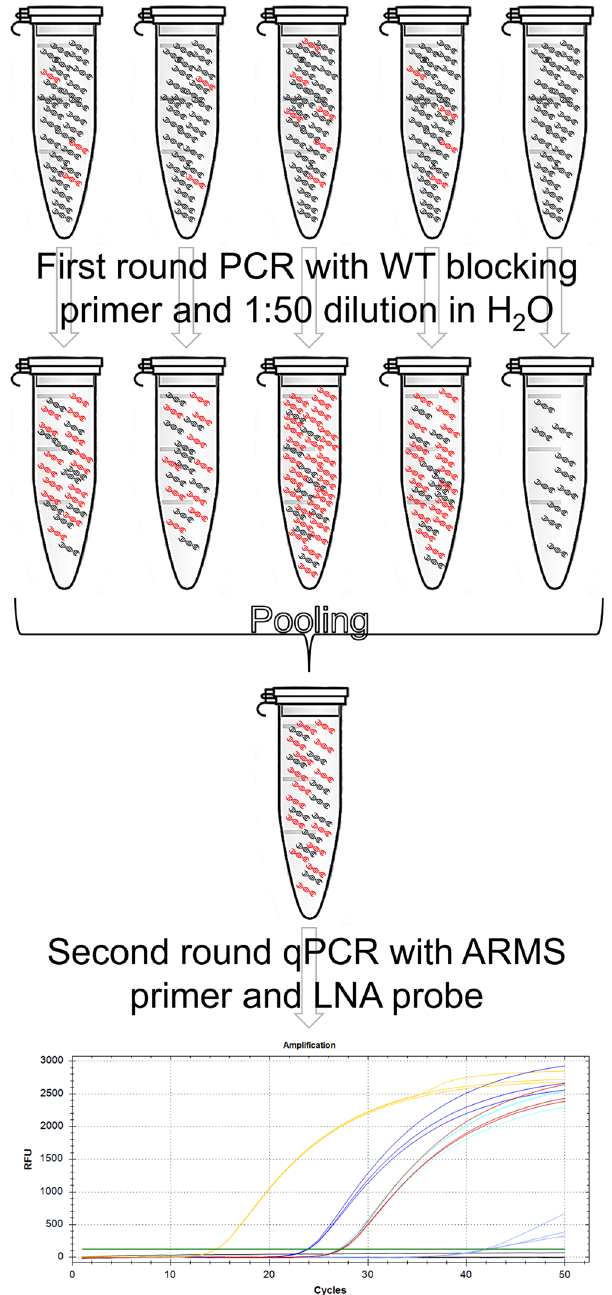
Figure 2. Scheme of the PNB-qPCR. The figure schematically displays the process of the PNB-qPCR with a hypothetical template containing an average of three mutated KRAS copies (in red) per PCR in a background of WT DNA (black). The mutated fraction is effectively enriched about 1000-fold. The additional pooling step of five first round products guarantees more accurate quantification in subsequent specific second round amplifications. It reduces variance in target template concentration following first round PCR, especially if low copy numbers of KRAS mutations had been present in the starting